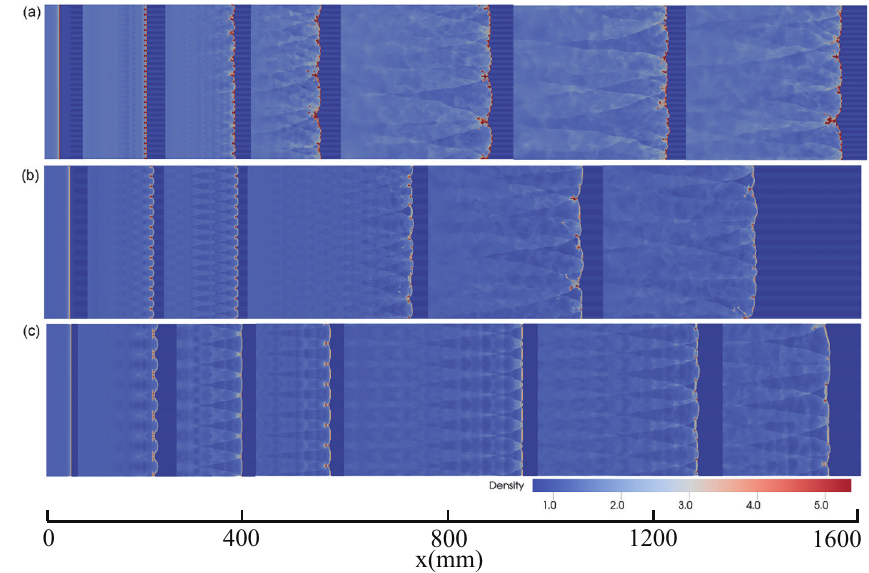
Figure 10. The evolution of detonation front ( k R = 3.0 s − 1 ) for cases with the same amplitude of A = 15 K but different wavelengths of ( a ) s = 10 ∆ I , ( b ) s = 20 ∆ I , and ( c ) s = 40 ∆ I